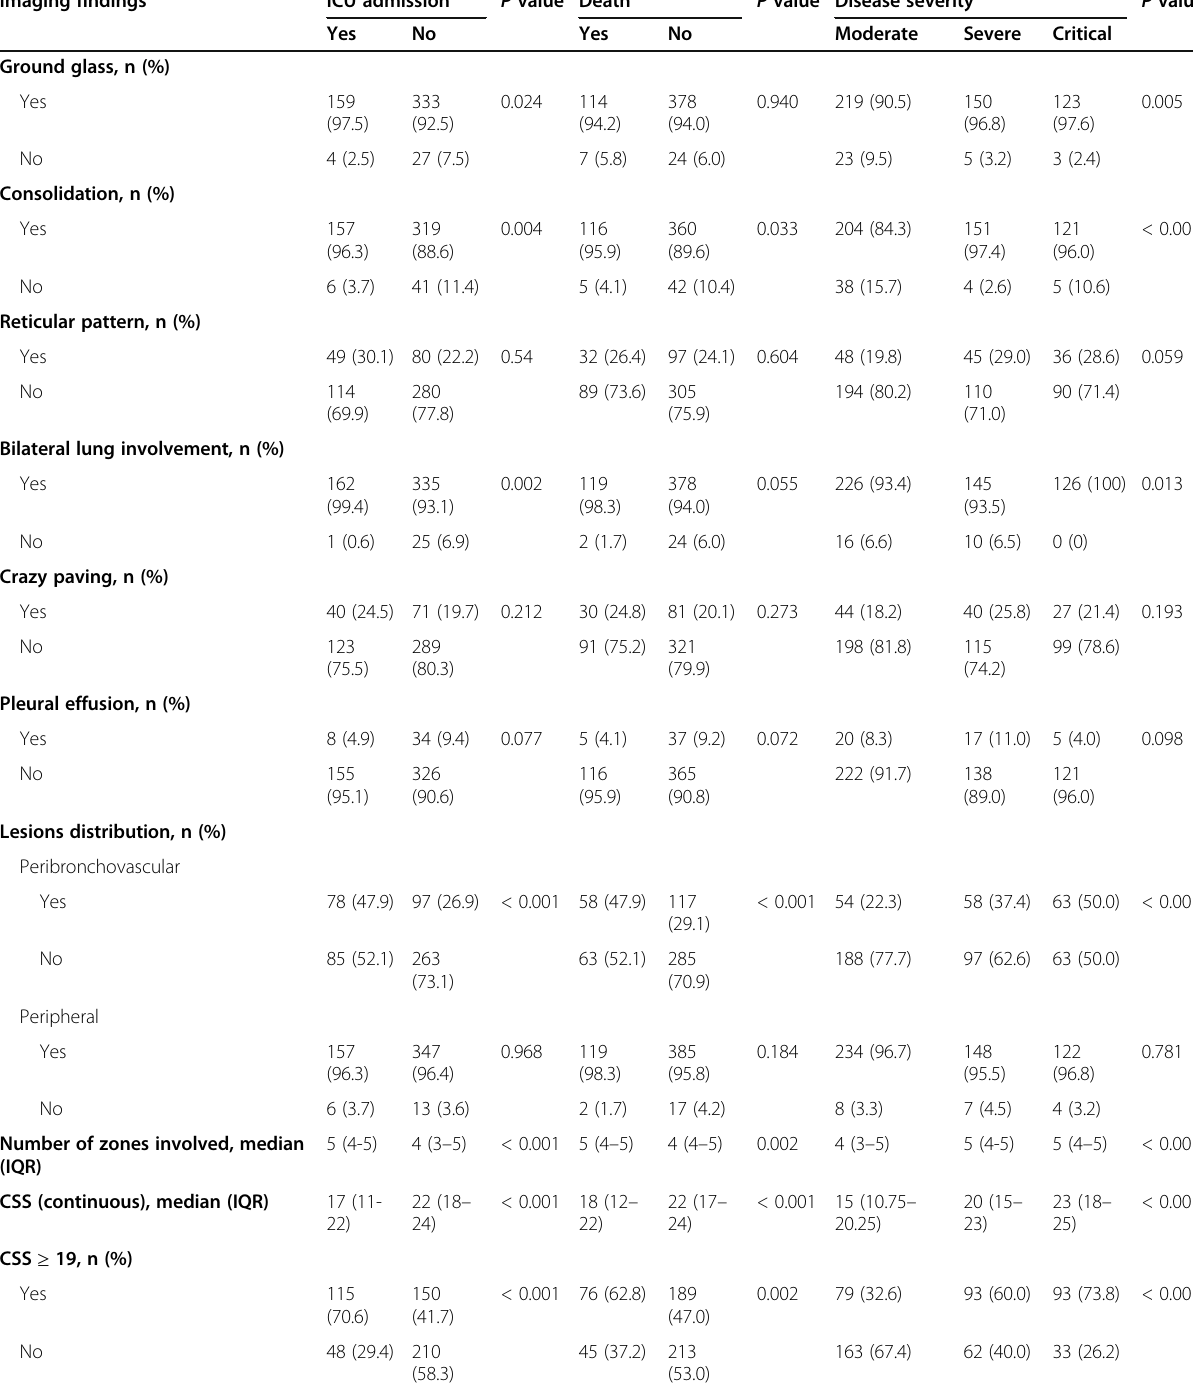
Table 4 Distribution of imaging findings by adverse clinical outcomes of COVID-19 Imaging